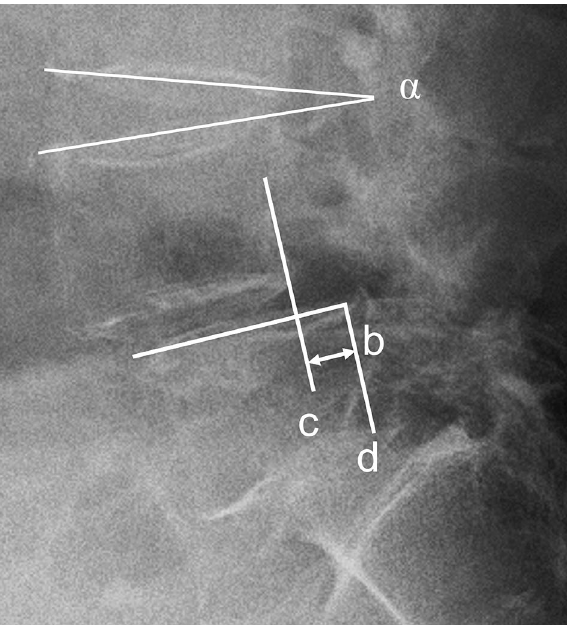
Figure 2. Radiographs of lumbar spine with spondylolisthesis to demonstrate the measurement technique. Sagittal translation (ST): first, the perpendicular distance between parallel lines c and d was measured on radiographs, the distance between these two parallel lines was the distance of slippage (b). The difference of the distance of slippage between flexion and extension was ST. Sagittal angulation (SA): the intervertebral slip angle(α) was the angle between two lines at the endplates of the affected disc. The difference of intervertebral slip angles between flexion and extension radiographs was